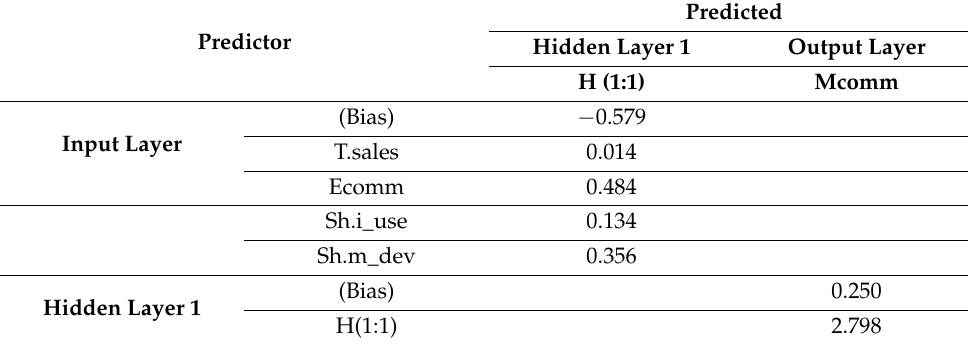
Table 4. The predictors of the MLP model.